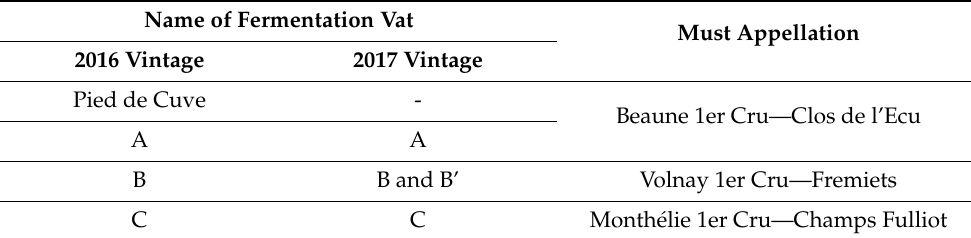
Table 1. Name and must appellation of each fermentation vats followed throughout the 2016 and 2017